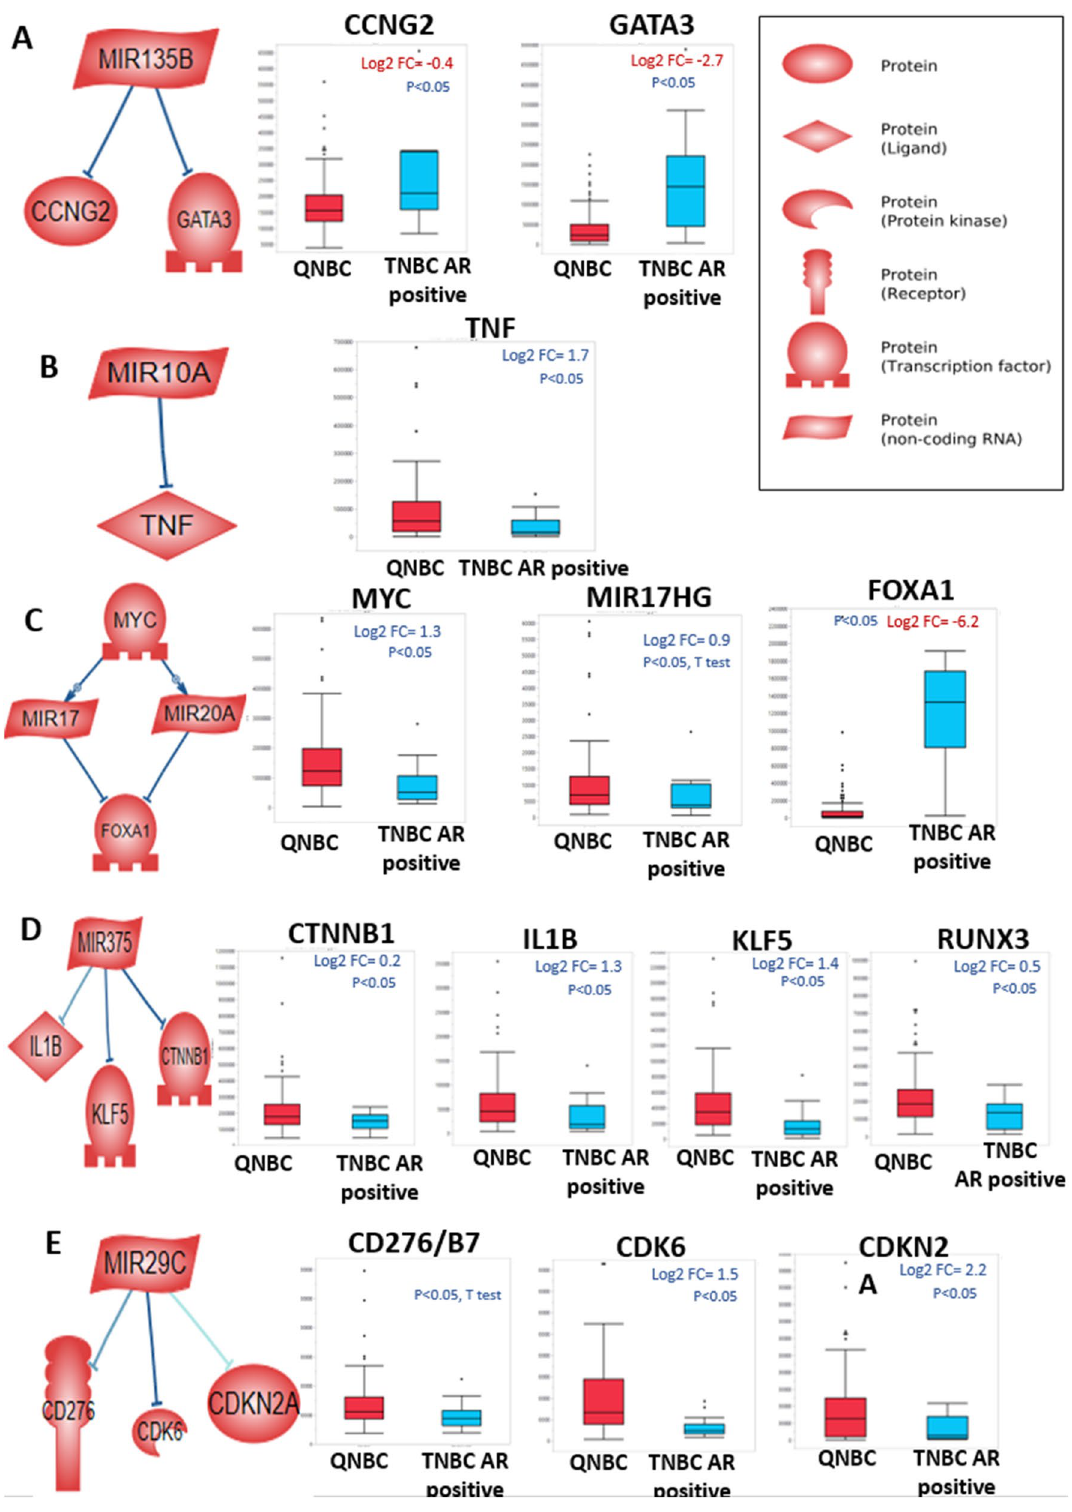
Figure 5. Genes associated with miRNAs are dysregulated in QNBCs. Predicted targets of miRNAs were obtained by use of Pathway Studio. The expression of gene targets was evaluated in QNBCs, and the correlations of miRNAs and genes were obtained for overall TCGA samples . Non-parametric Wilcoxon test p -values are presented. ( A ) mir-135b targets CCNG2 and GATA3, the expressions of which were lower in QNBCs. ( B ) mir-10a targets TNFα, the expression of which was higher in QNBCs. ( C ) Pathway Studio networks revealed that MYC positively regulates mir-17 and -20a, which target FOXA1. MYC and mir-17HG were higher in QNBCs, and FOXA1 was lower in QNBCs. ( D ) Pathway Studio analysis showed that mir-375 targets IL-1B, KLF5, and CTNNB1. Literature reports show that mir-375 targets RUNX family proteins 55 . We observed that IL1B, KLF5, CTNNBA, and RUNX3 are upregulated in QNBCs. ( E ) From network analysis, Pathway Studio revealed that mir-29C targets CD276, CDK6, and CDKN2A. In QNBCs, CD276 ( p < 0.05 by T-test and p = 0.05 by Wilcoxon), CDK6, and CDKN2A are